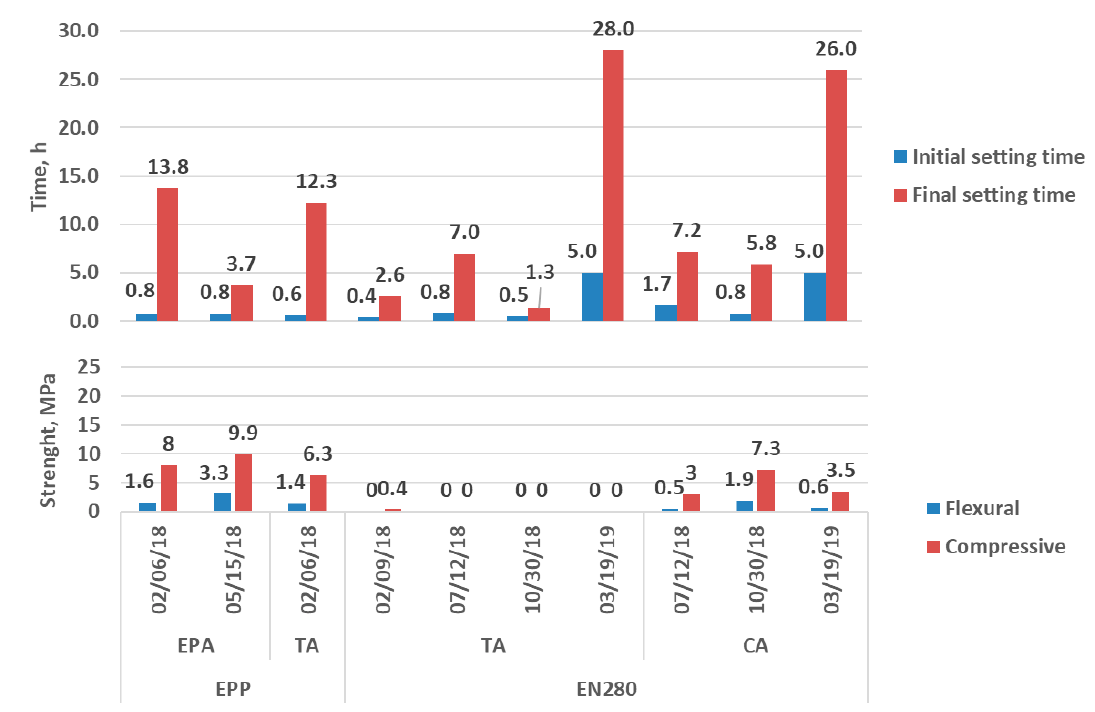
Figure 5. S etting times and Self-cementitious ability for APP-EPA and APP-TA.